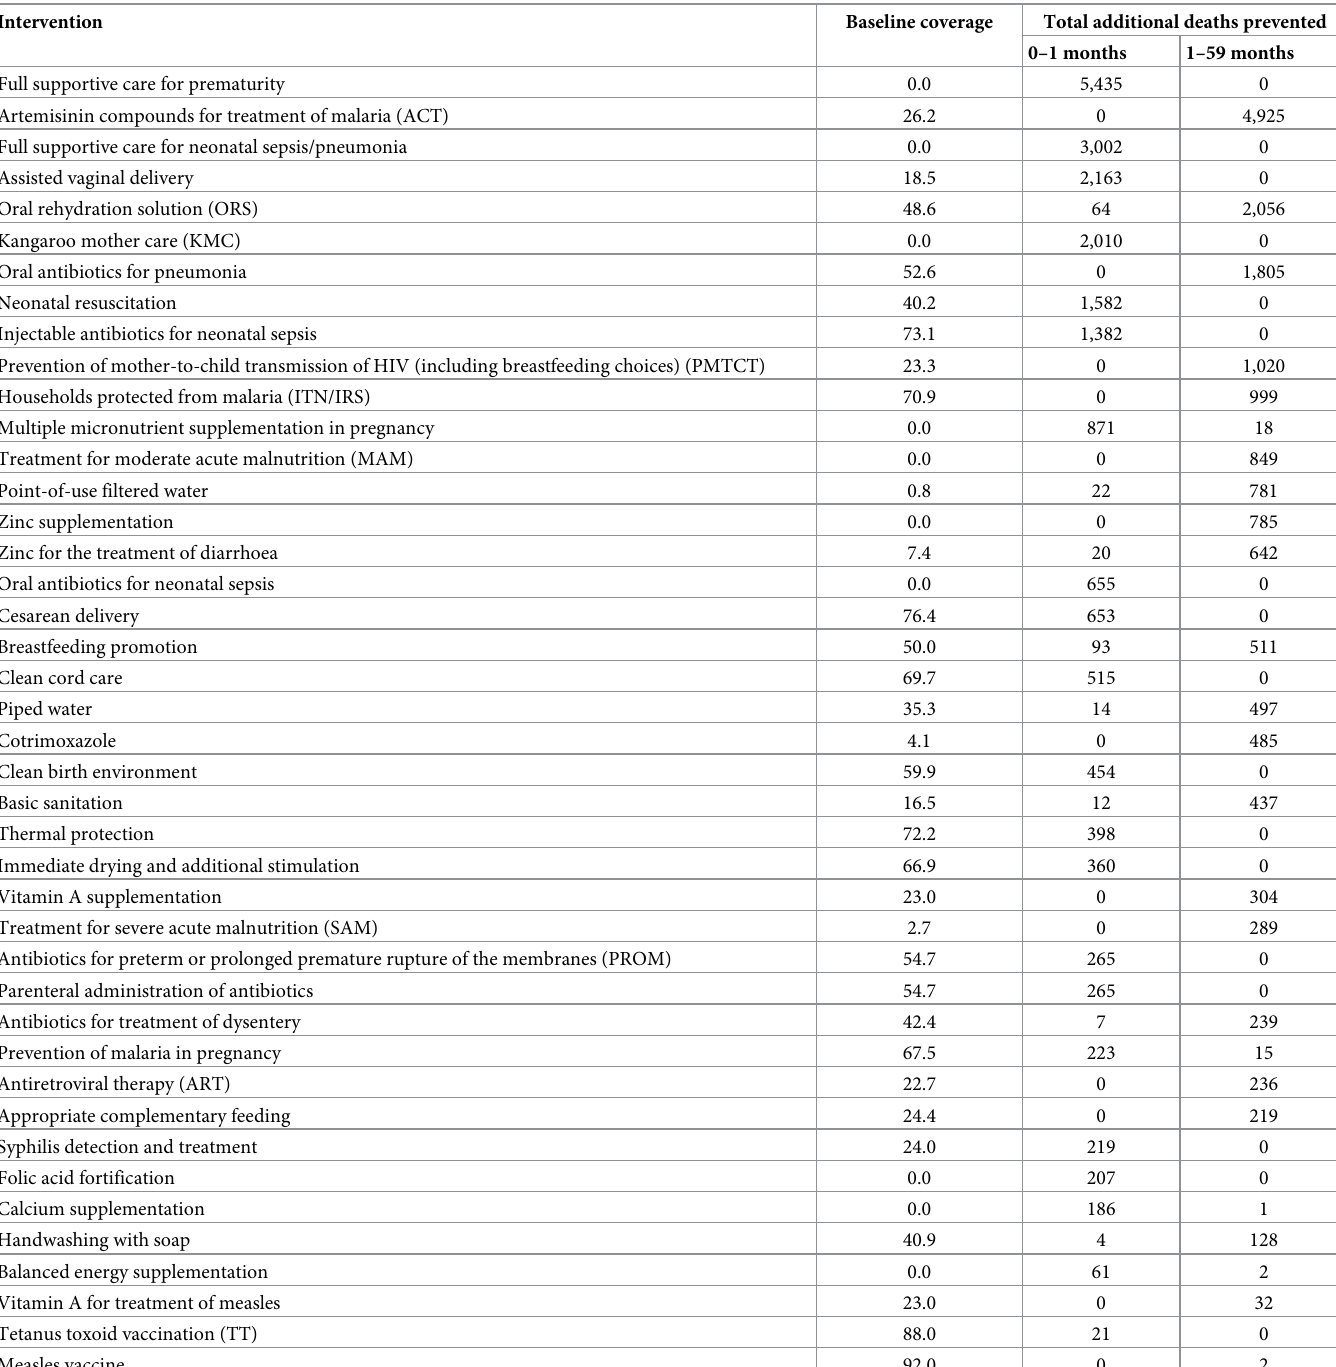
Table 2. Lives saved at 90% intervention coverage level, one intervention at a time among children 0–59